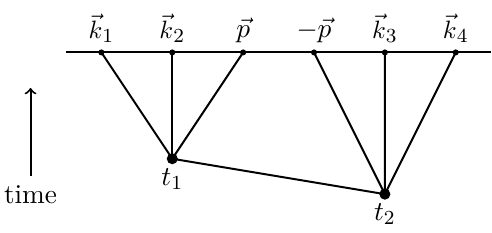
Figure 3 . Tree level